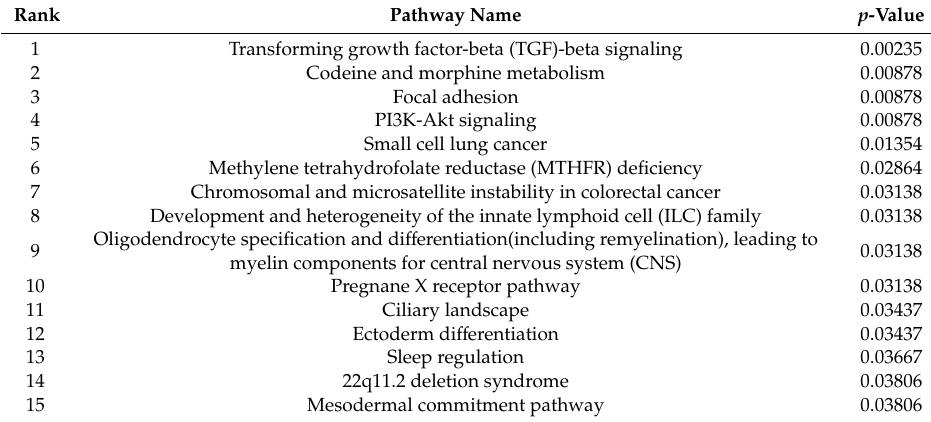
Table 1. The top-15 ranked pathways obtained from GeneTrial3 for pre-symptomatic HD using